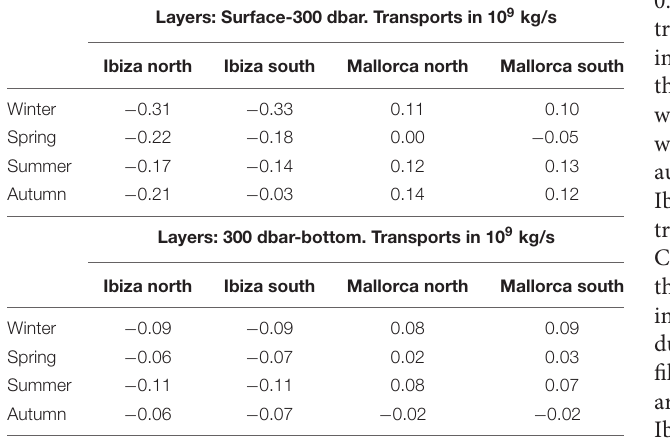
Frontiers in Marine Science |